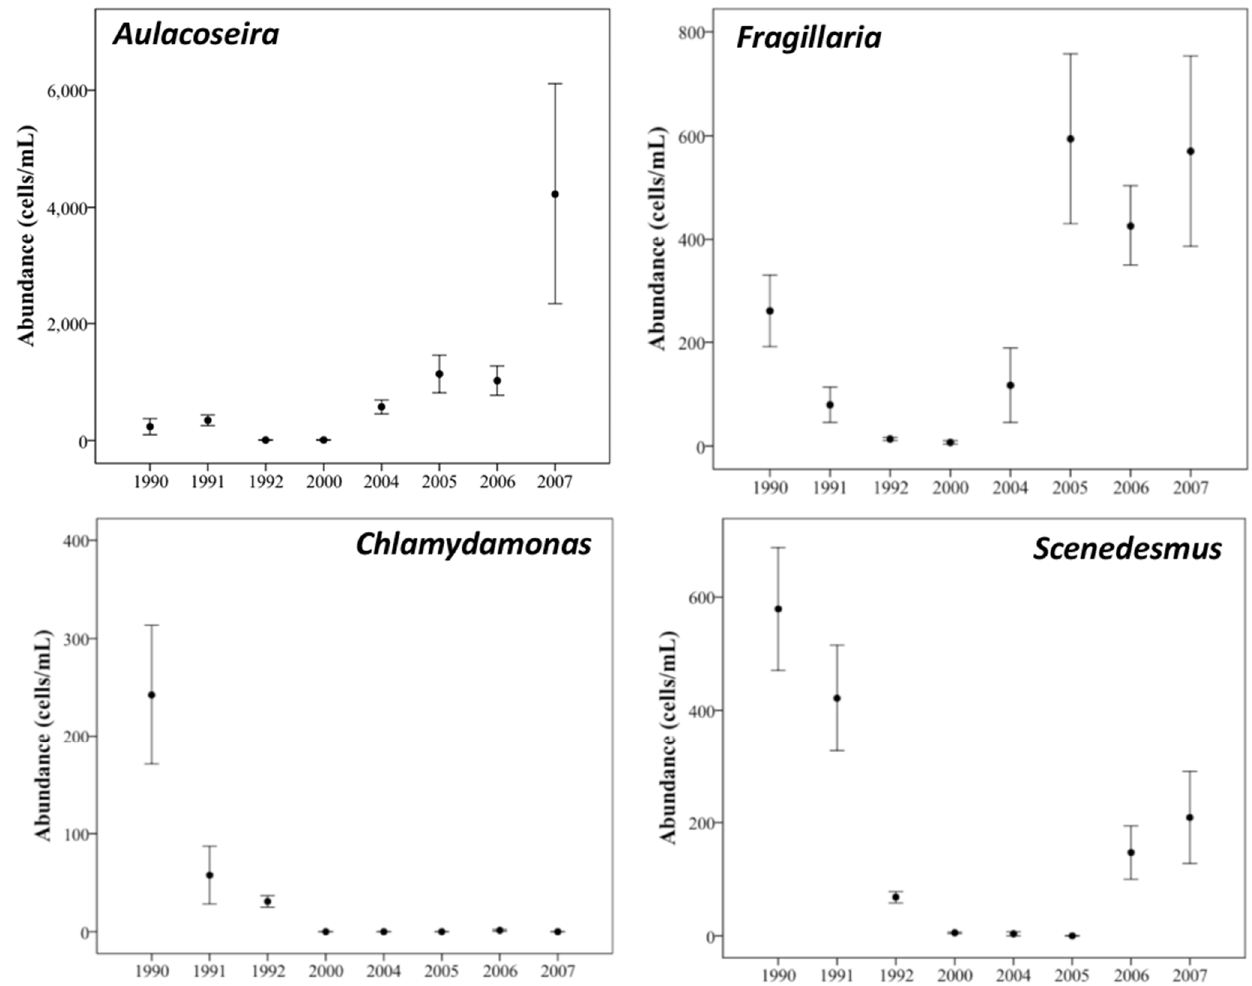
Figure 10. Summer mean abundance of select diatoms (upper panels) and green algae (lower panels) for the inner bay of Green Bay. Error bars indicate ±1 SEM. Note changes in scales between